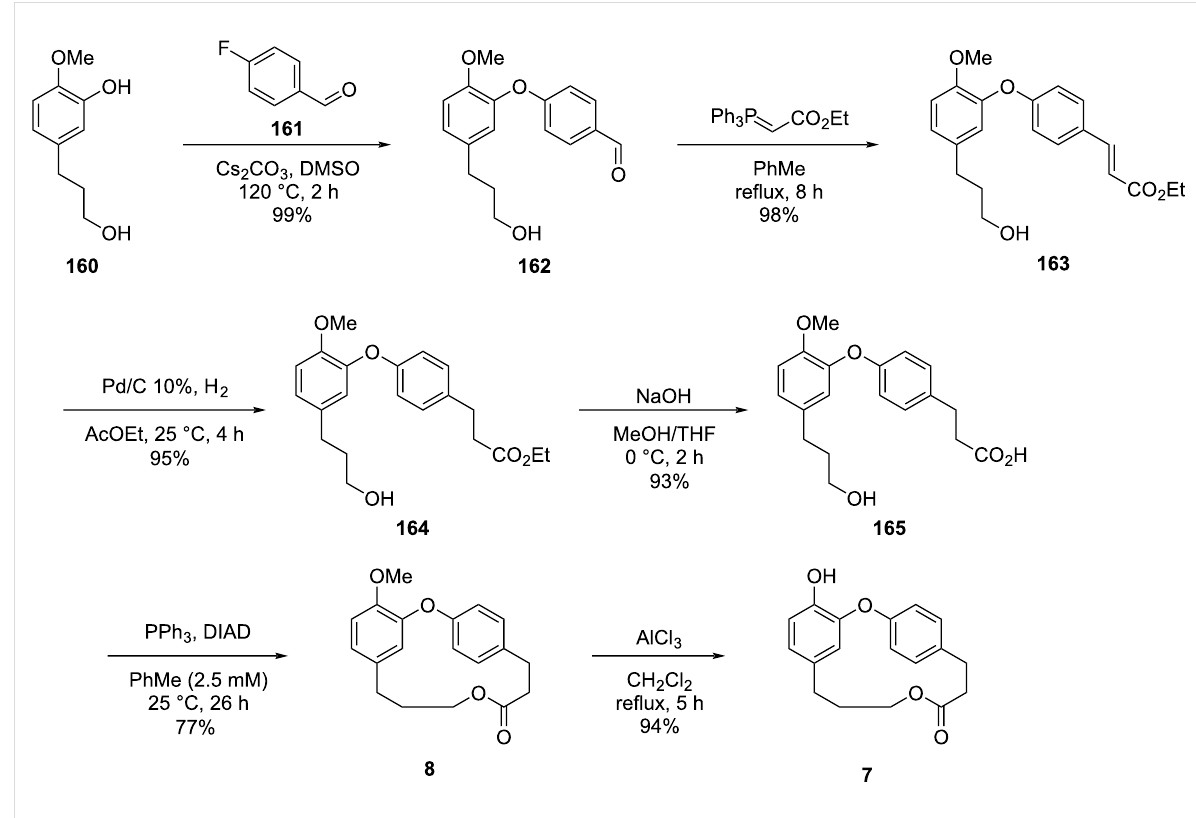
Scheme 32: Synthesis of isocorniculatolide A ( 7 ) and O -methylated isocorniculatolide A 8 by Raut and co-workers